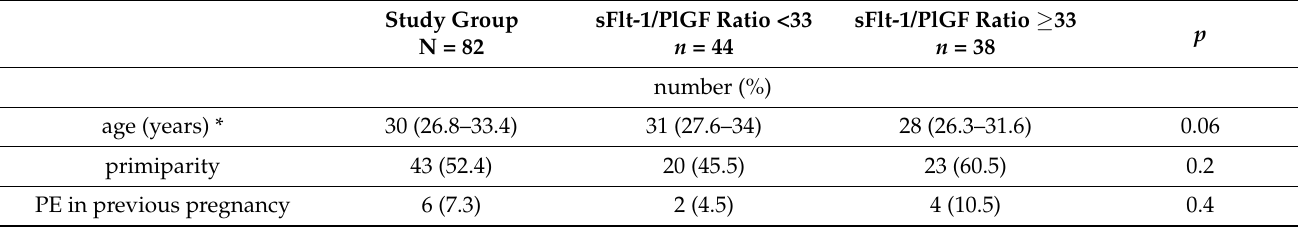
Table 1. Basic characteristics of the study